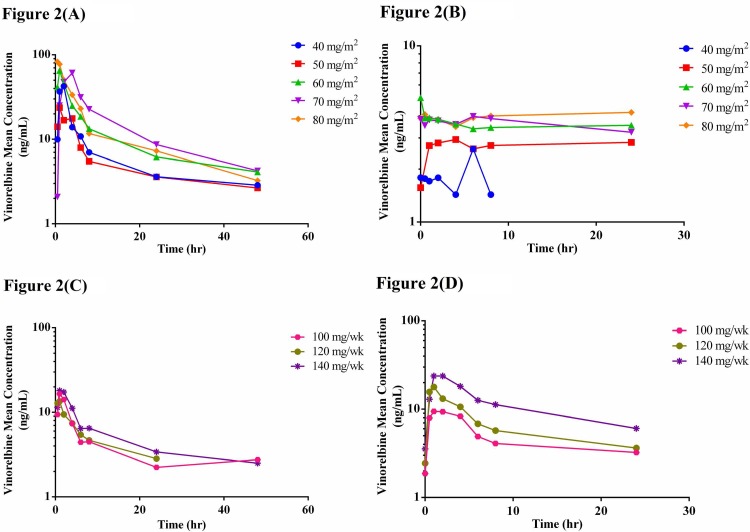
Mean plasma concentration-time curves of vinorelbine (A) on Day 1 after initial oral dose with CSV schedule, (B) on Day 10 at steady state after oral dose with CSV schedule, (C) on Day 1 after initial oral dose with MSV schedule, and (D) on Day 10 at the steady state after oral dose with MSV schedule.